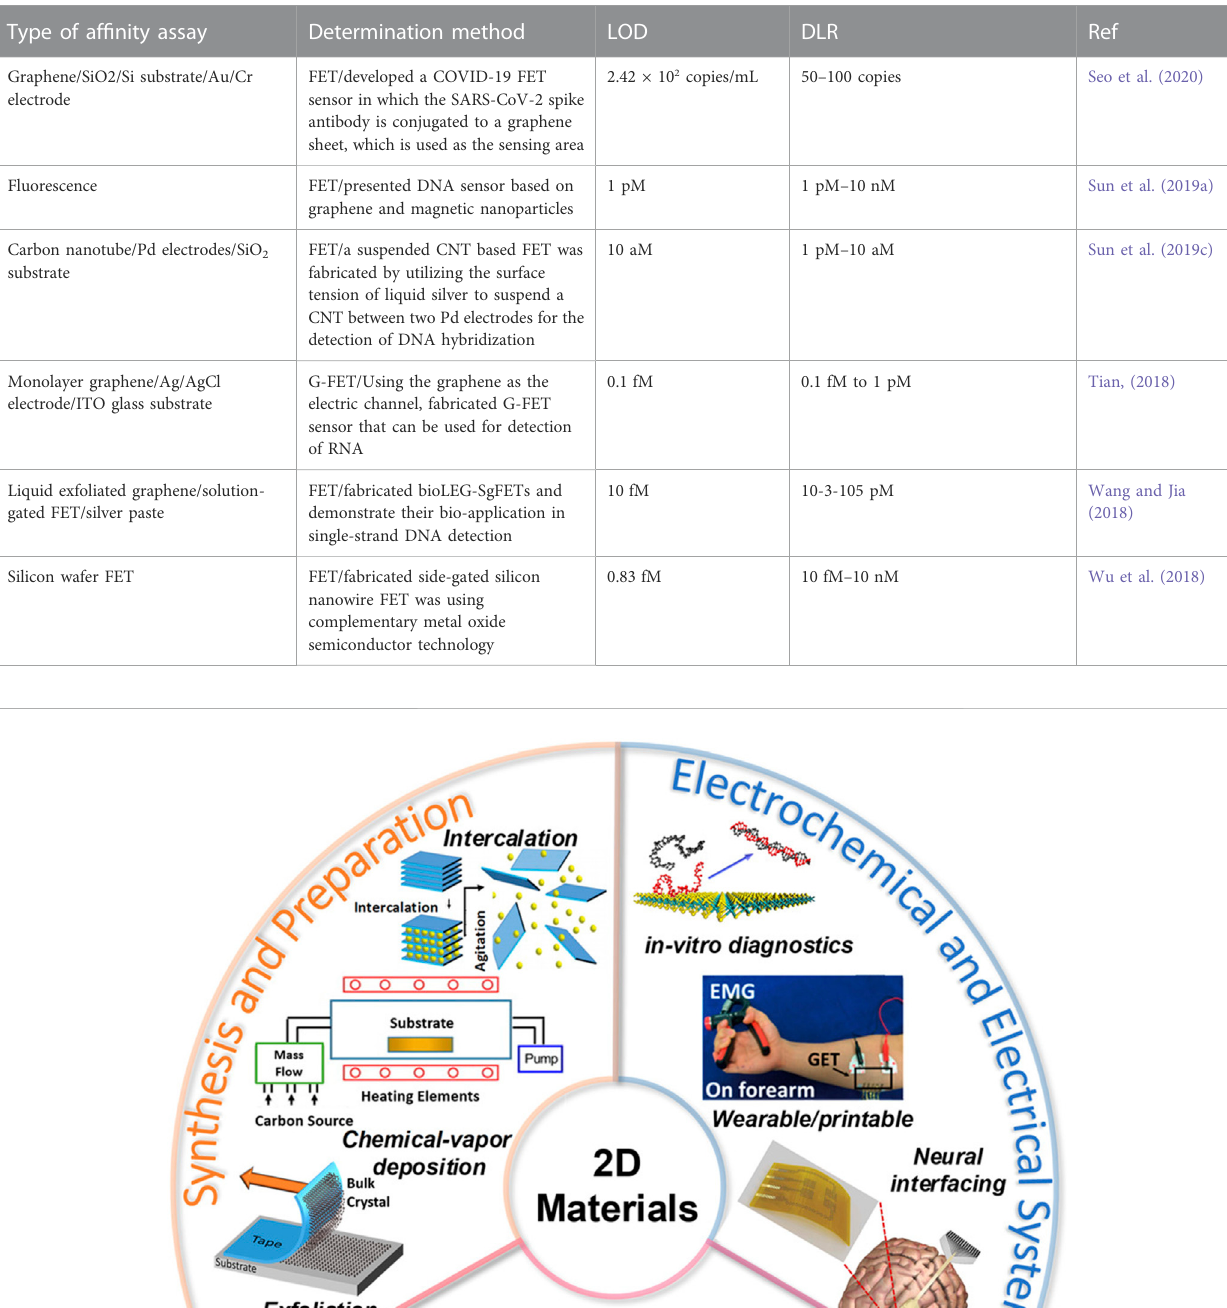
Frontiers in Bioengineering and